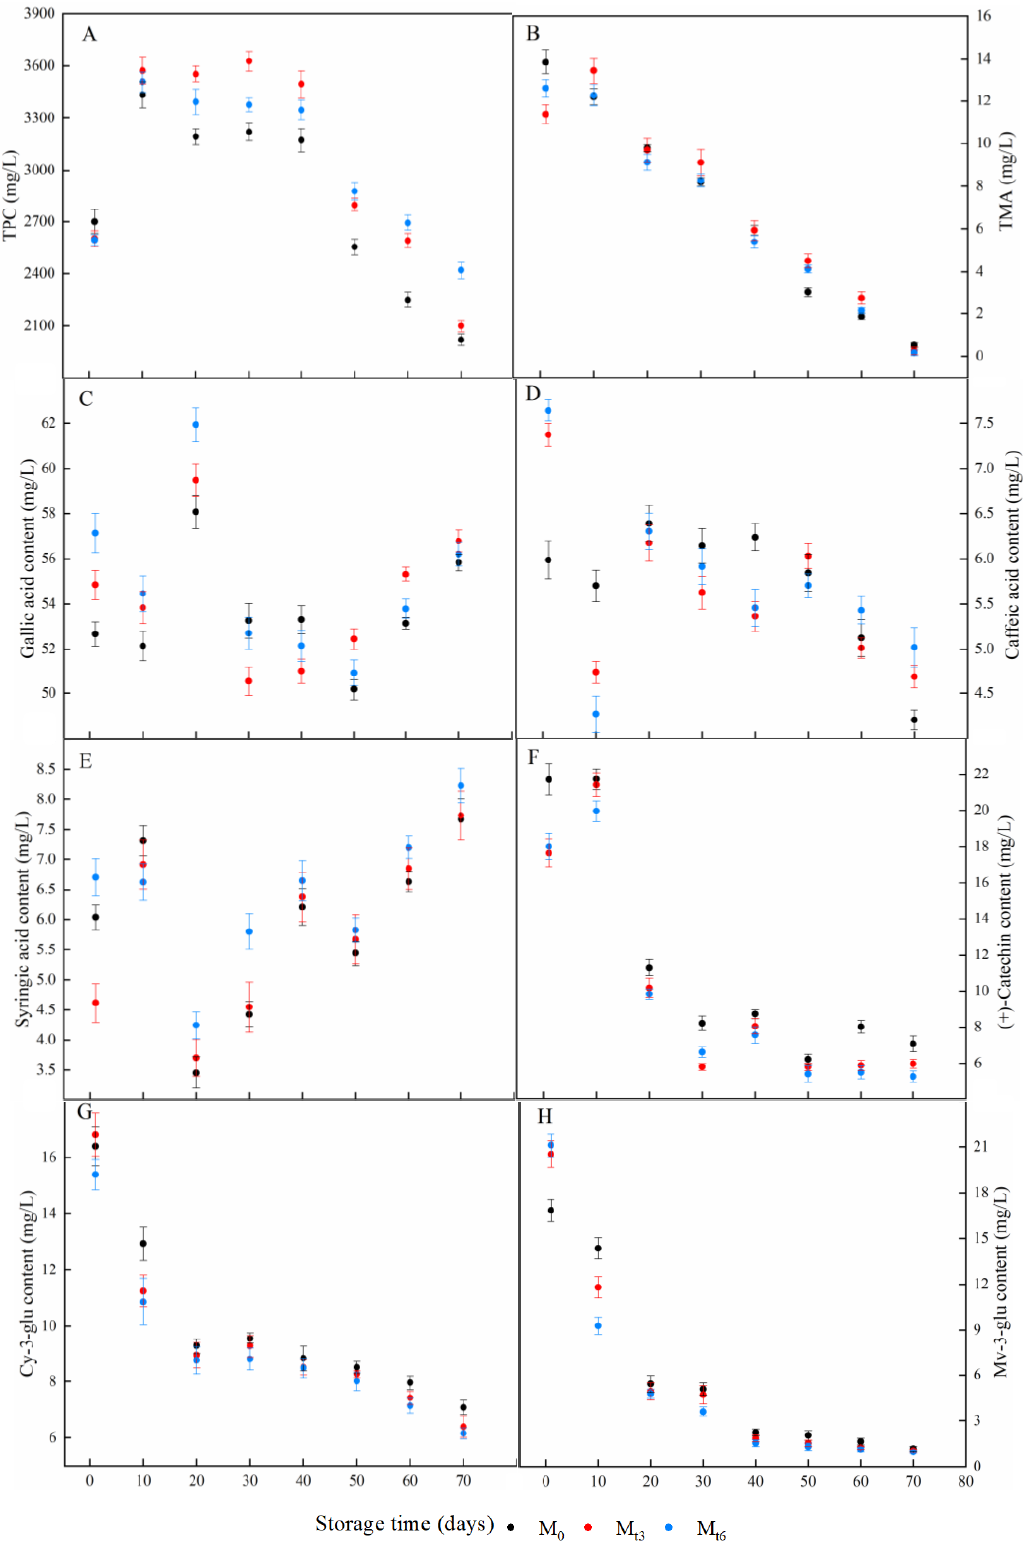
Figure 3. The content changes of phenolics in M 0 , M t3 , and M t6 during storage. ( A ) TPC; ( B ) TMA; ( C ) gallic acid; ( D ) caffeic acid; ( E ) syringic acid; ( F ) (+)-catechin; ( G ) Cy-3-glu; ( H ) Mv-3-glu.